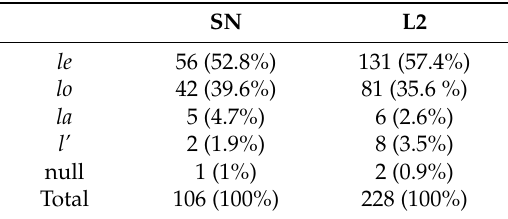
Table 5. Distribution of clitics and null